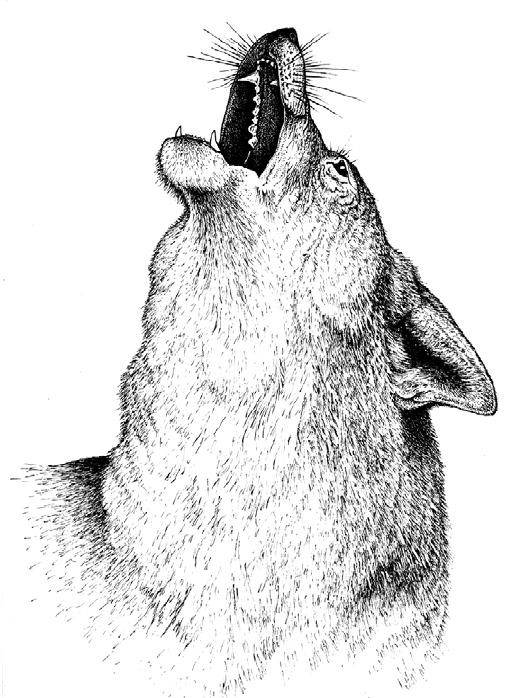
Image 13. Jackal Canis aureus . Illustrated using technical pen (Rotring .30) for the magazine Shikra (Anon.